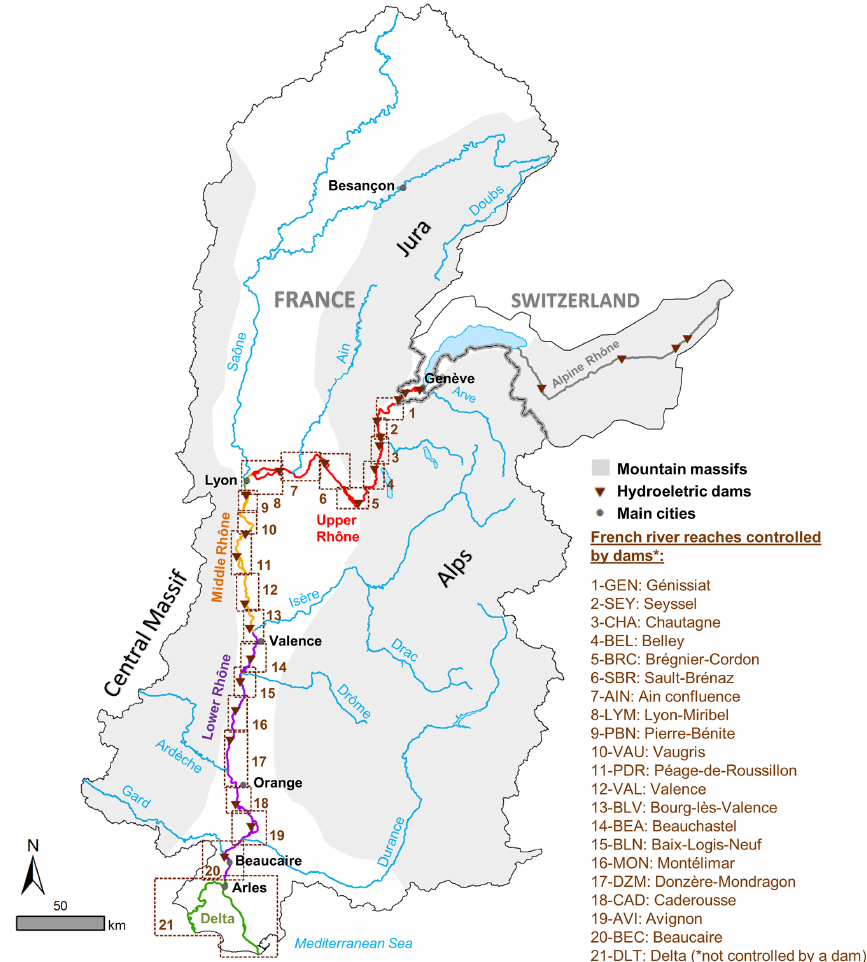
Figure 1. The Rhône River corridor in the French–Swiss